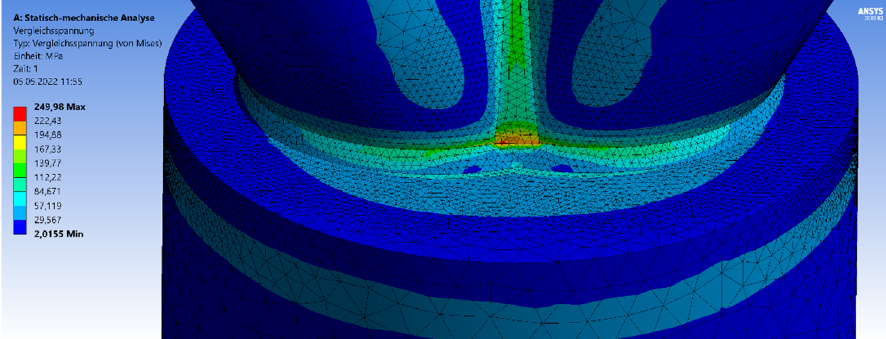
Figure 13. Stresses 60° Model.